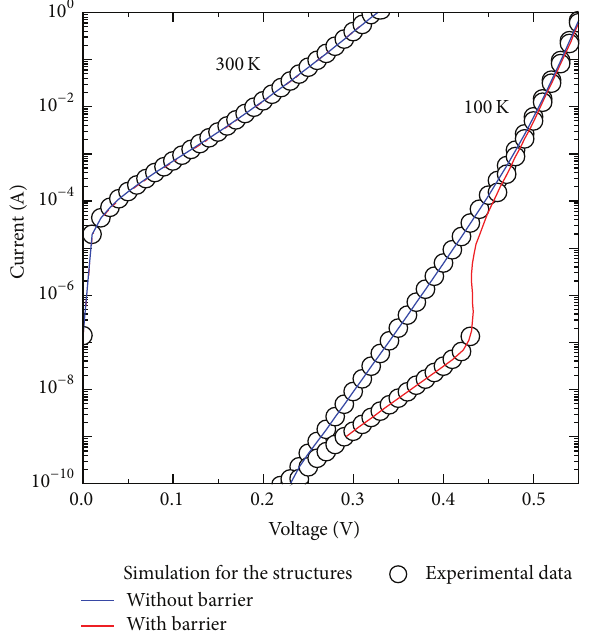
Figure 12: The simulated IV curves for the heterostructures with and without a potential barrier at the GaInP/Ge interface at 300 and 100